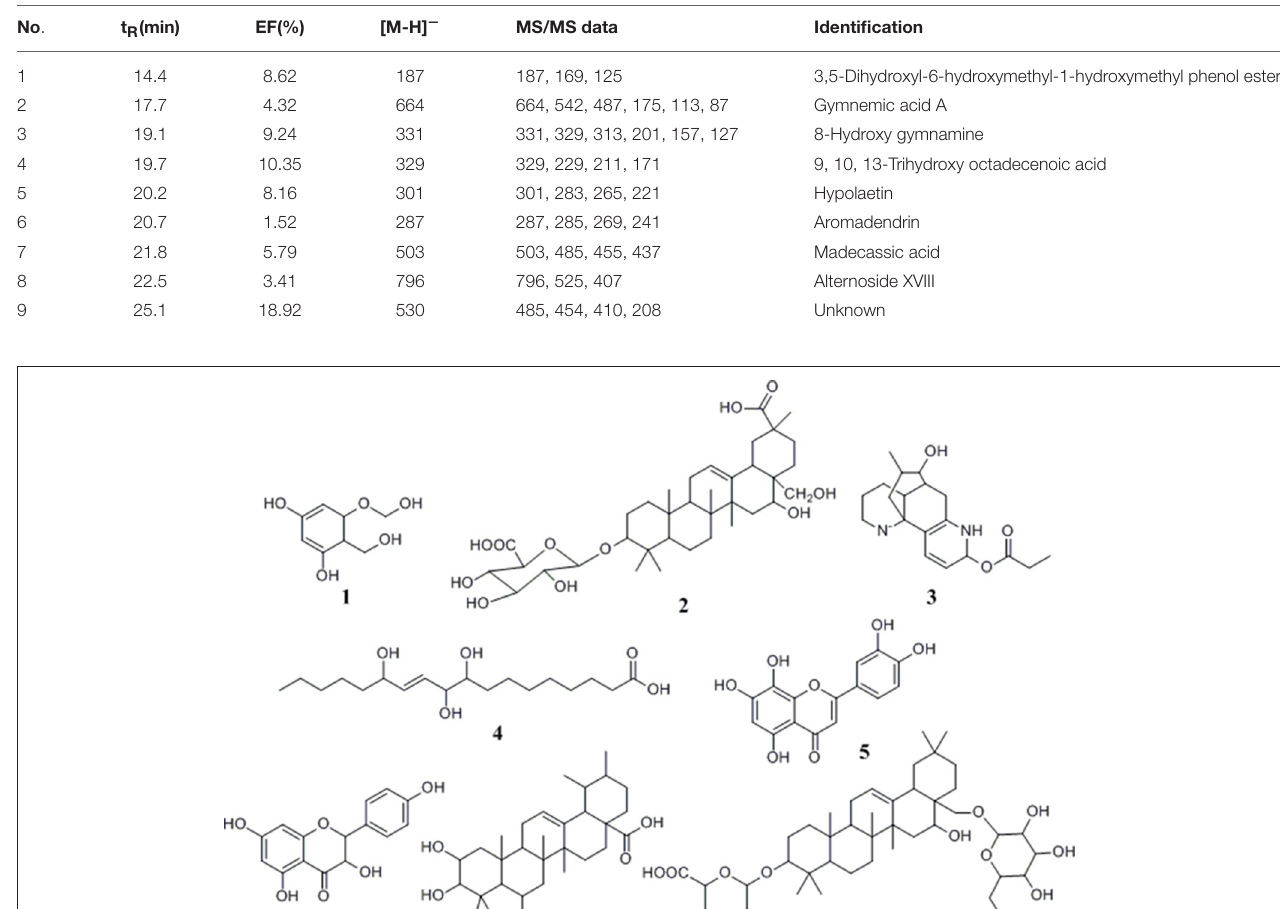
TABLE 1 | The enrichment factors (EF) and the UF-HPLC-MS data of potential inhibitors of α -glucosidase from the G. sylvestre . No .